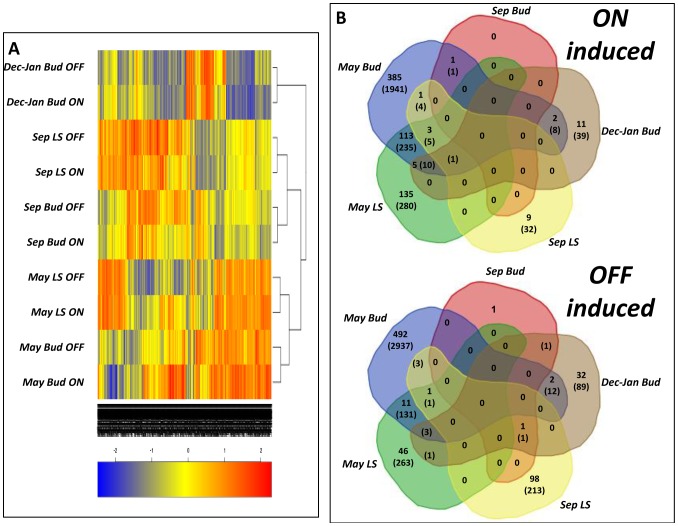
Differences in global gene expression in ON- vs. OFF-crop trees.Hierarchical cluster analysis of global gene expression in buds and leaves+stems (LS) in ON-crop (On) and OFF-crop (Off) trees at the indicated times (A). Venn diagrams of differentially expressed probes, induced in buds and LS of ON- and OFF-crop trees during the indicated months.